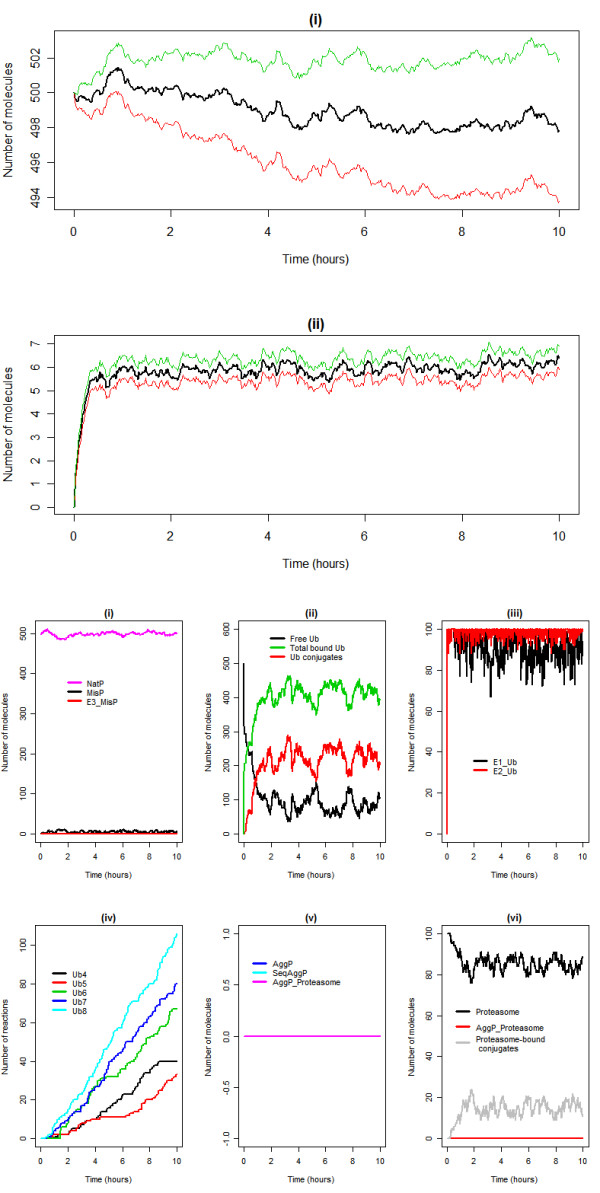
Model output under normal conditions. (a) Stochastic variation. Simulations were repeated 100 times and the mean for two of the species plotted. The black lines show the mean values, the green and red lines show the upper and lower 95% confidence interval respectively. (i) Native protein (NatP). (ii) Misfolded protein (MisP). (b) Results are shown for a typical simulation, for a 10 hour period. (i) Level of native protein (NatP), misfolded protein (MisP), and misfolded protein bound to E3 (E3_MisP). (ii) Ubiquitin pools. (iii) Ubiquitin bound to E1 and E2 (E1_Ub and E2_Ub respectively). (iv) Cumulative number of degradation reactions for different length of ubiquitin chains bound to substrate. (v) Accumulation of aggregated protein (AggP), sequestered aggregated protein (SeqAggP) and aggregated protein bound to proteasomes (AggP_Proteasome). (vi) Available pool of proteasomes, number of proteasomes bound by substrates and number of proteasomes bound by aggregated proteins.